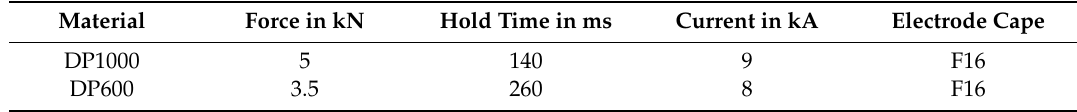
Table 2. Welding parameters for the RSW.